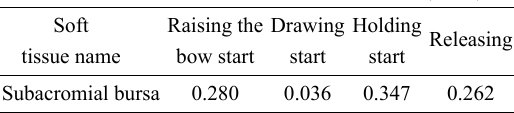
Table 3. Stress peak of the subacromial bursa at each characteristic actions of the recurve bow